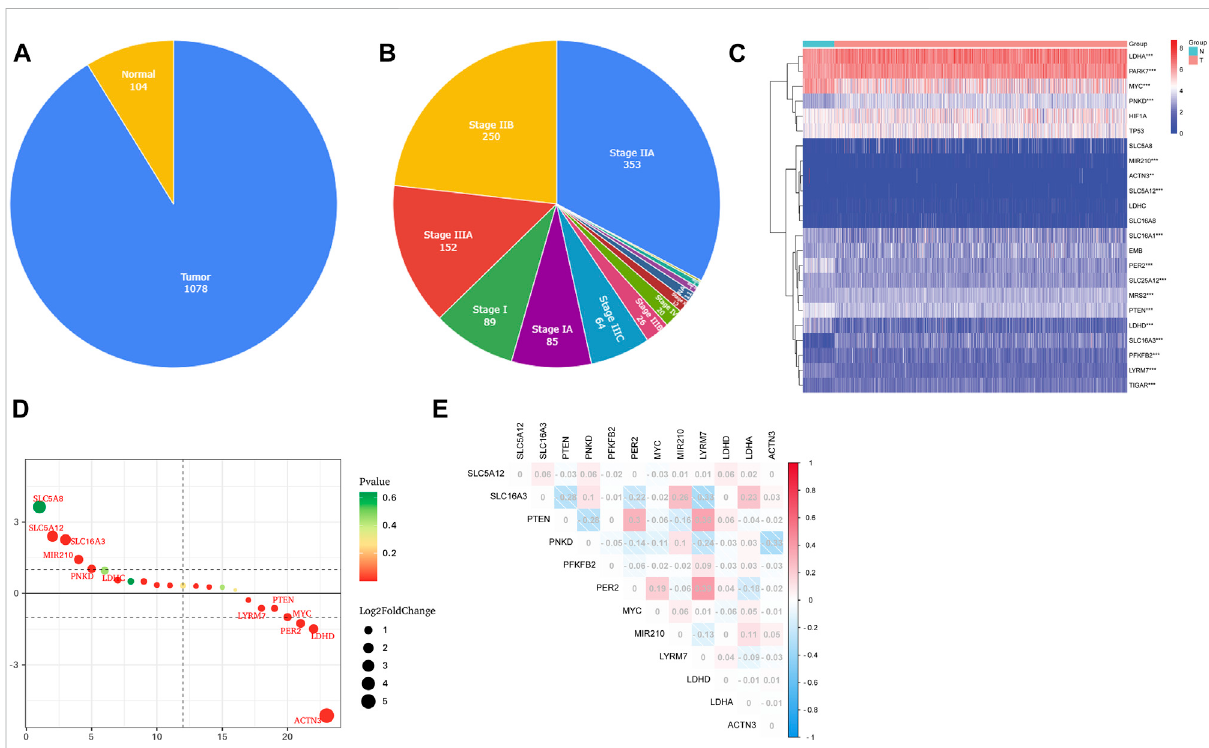
FIGURE 1 Characteristics of TCGA BC patients and expressions of the LMRGs. (A,B) Clinicopathological of all patients included in this study. (C) Heatmap (blue: low expression level; red: high expression level) of the LMRGs between the normal (N, brilliant blue) and tumor tissues (T, red). p -values were shown as * p < 0.05; ** p < 0.01; and *** p < 0.001. (D) Gene ranking dot plot (The redder the color, the closer the p -value is to zero; the bigger the circle, the taller the | log2FC |). (E) Interaction analysis among the 12